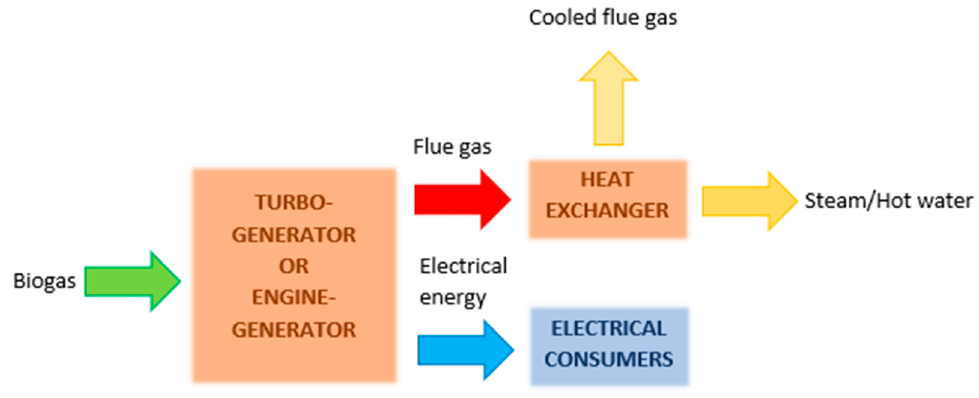
Figure 1. Simple diagram of a cogeneration unit.